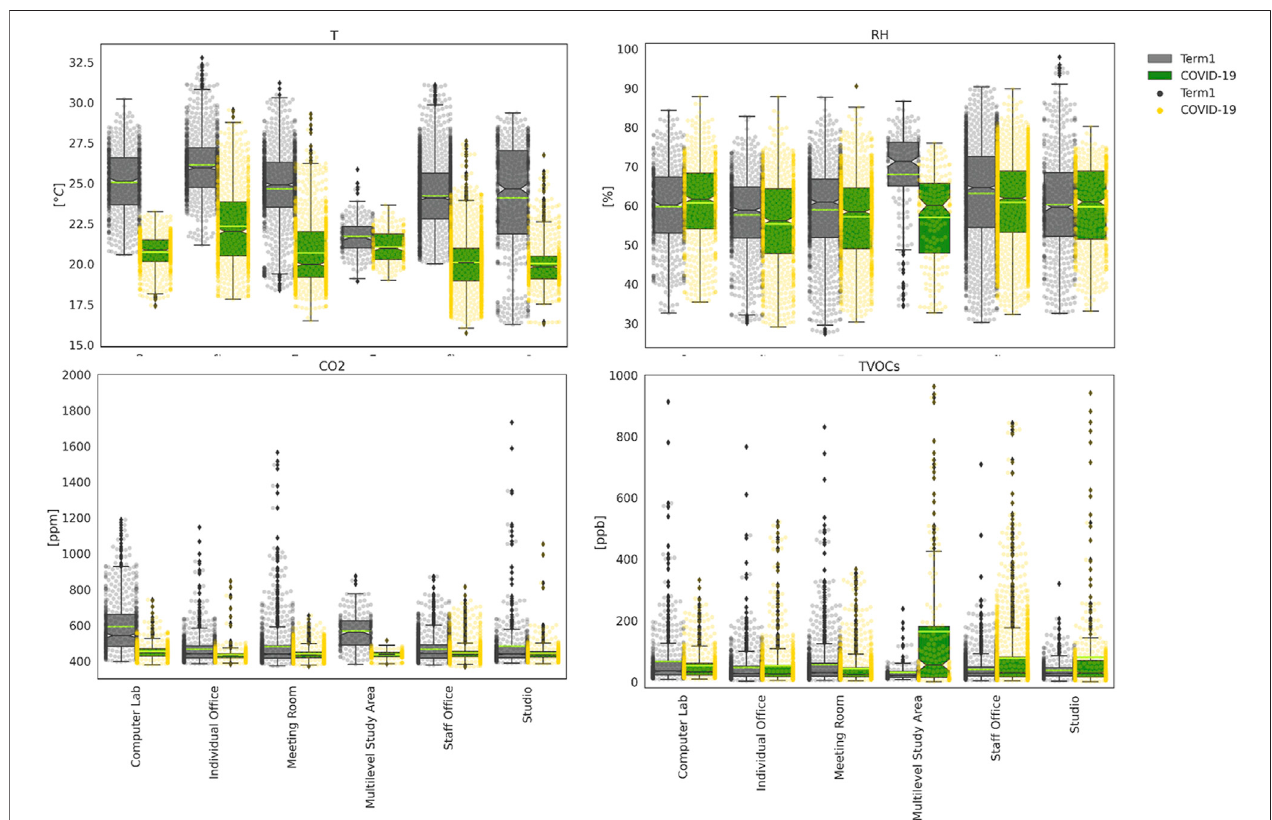
FIGURE 10 | IEQ behaviour across different room types: comparison between warm standard occupancy period and COVID-19 lockdown. Boxplots and overlapped swarmplots show mean observations, on hourly basis during occupied hours and workdays only.